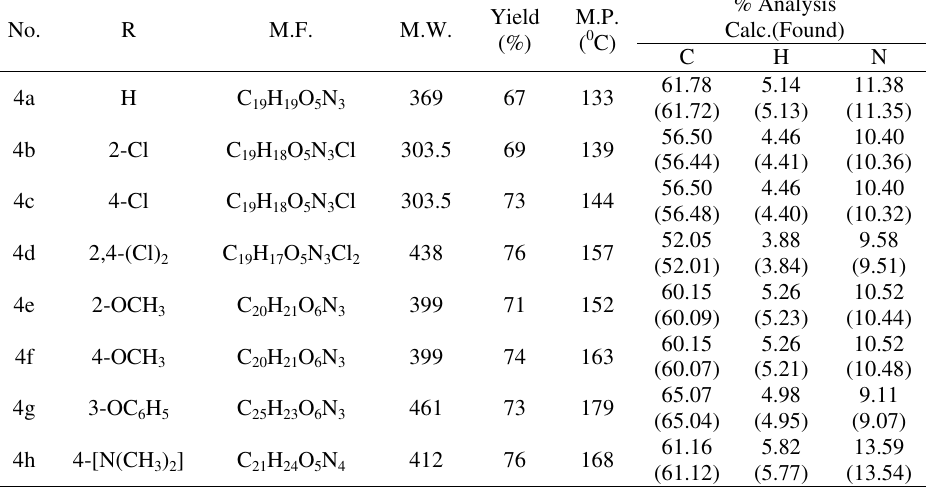
Table-2 Characterization data of compounds